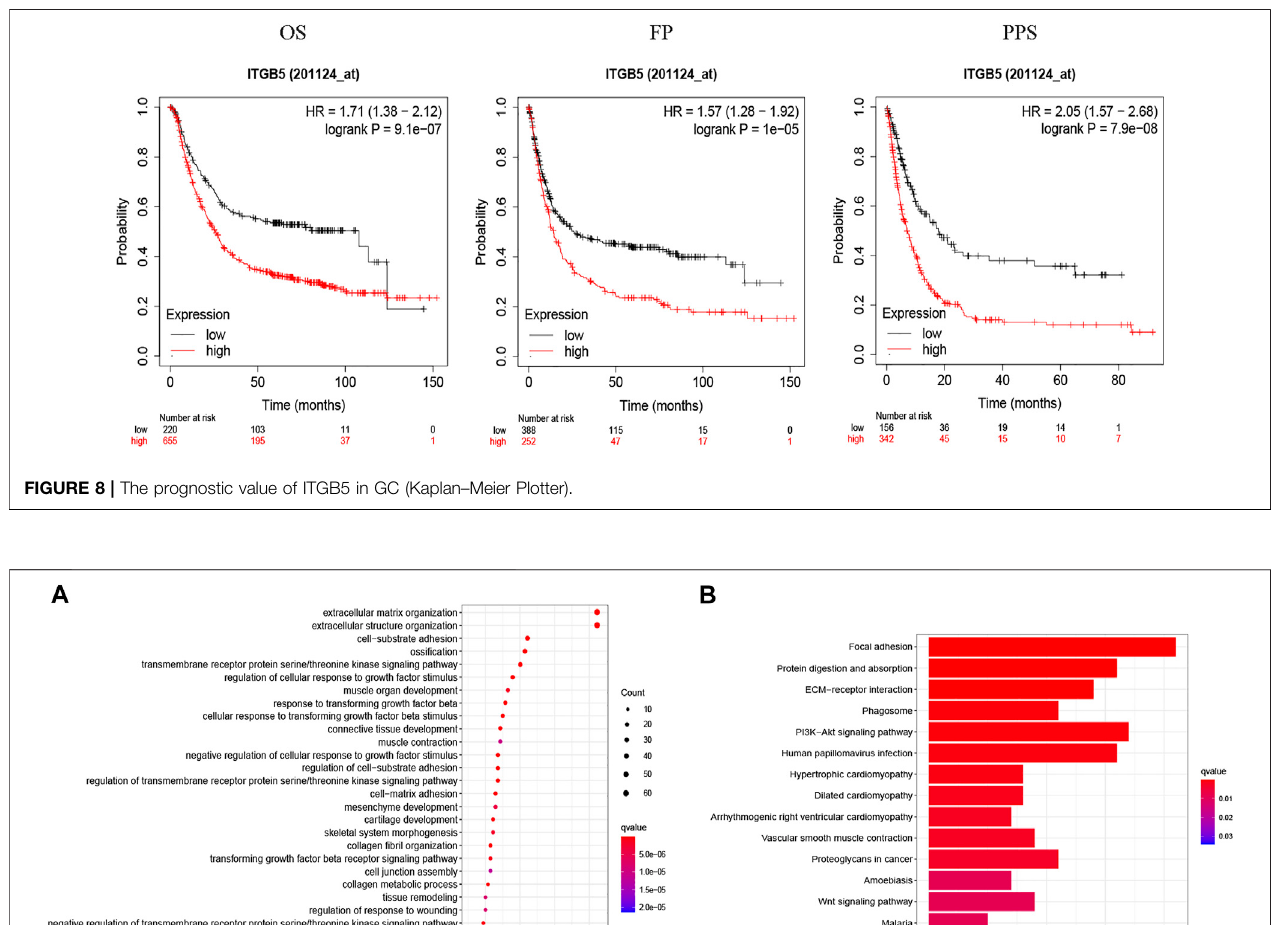
Frontiers in Cell and Developmental Biology |